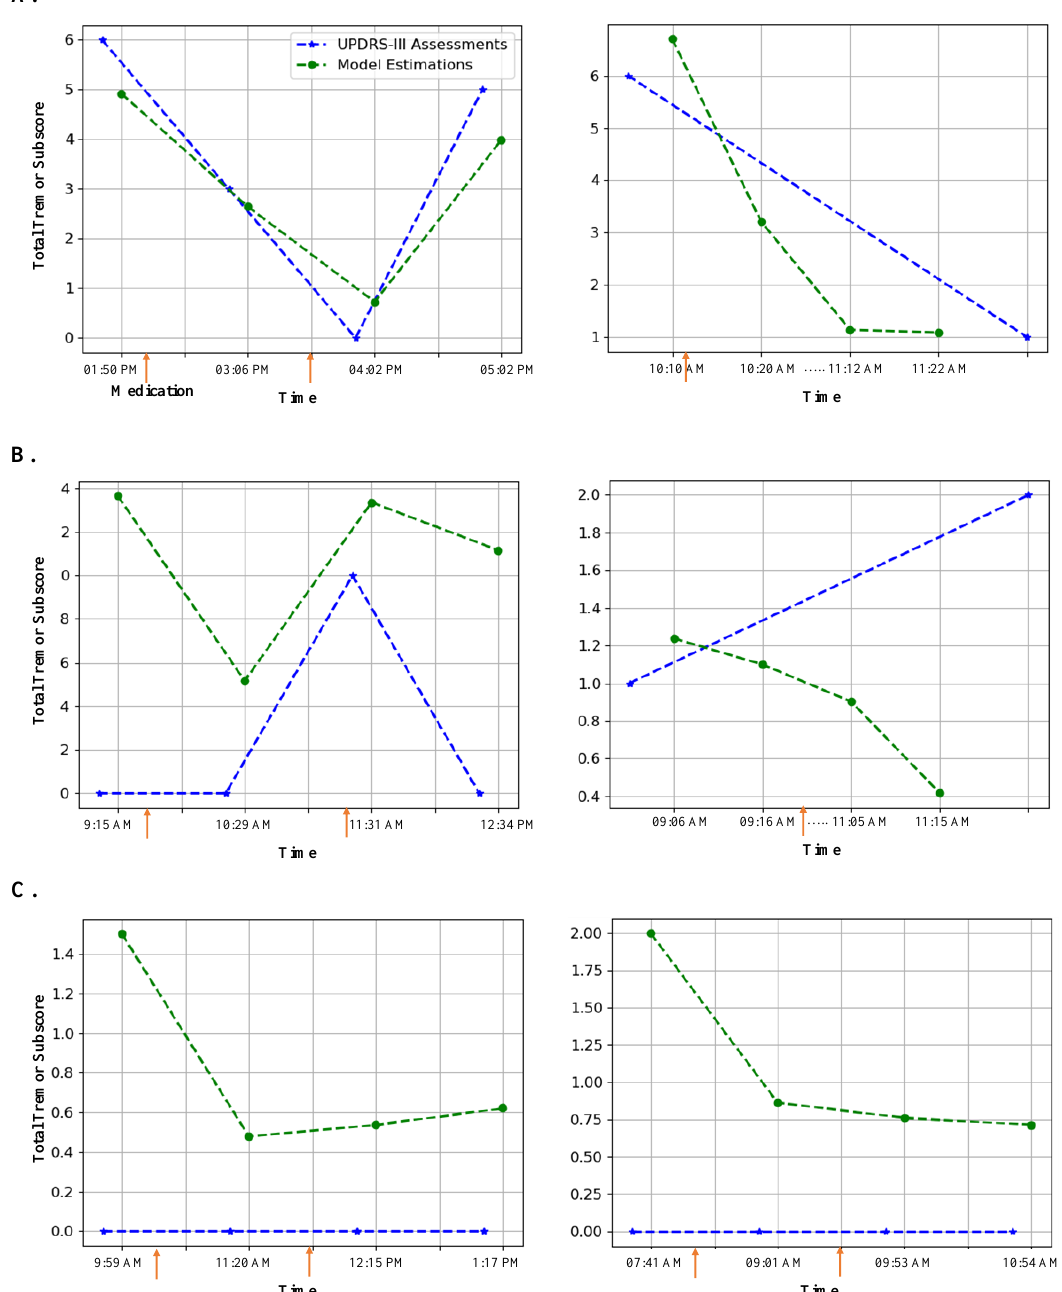
Figure 3. Examples of total tremor estimation over time using the gradient tree boosting model in comparison with the estimation from the UPDRS-III assessment. ( A ) Two examples with high correlation; ( B ) Two examples with moderate to low correlation; ( C ) Two examples from non-tremor-dominant subjects. The PD medication intake time is denoted as an orange arrow. Note that in cases of the subjects in the right-hand side of A-B, only two UPDRS-III assessments were performed while four tremor estimations were performed using our developed